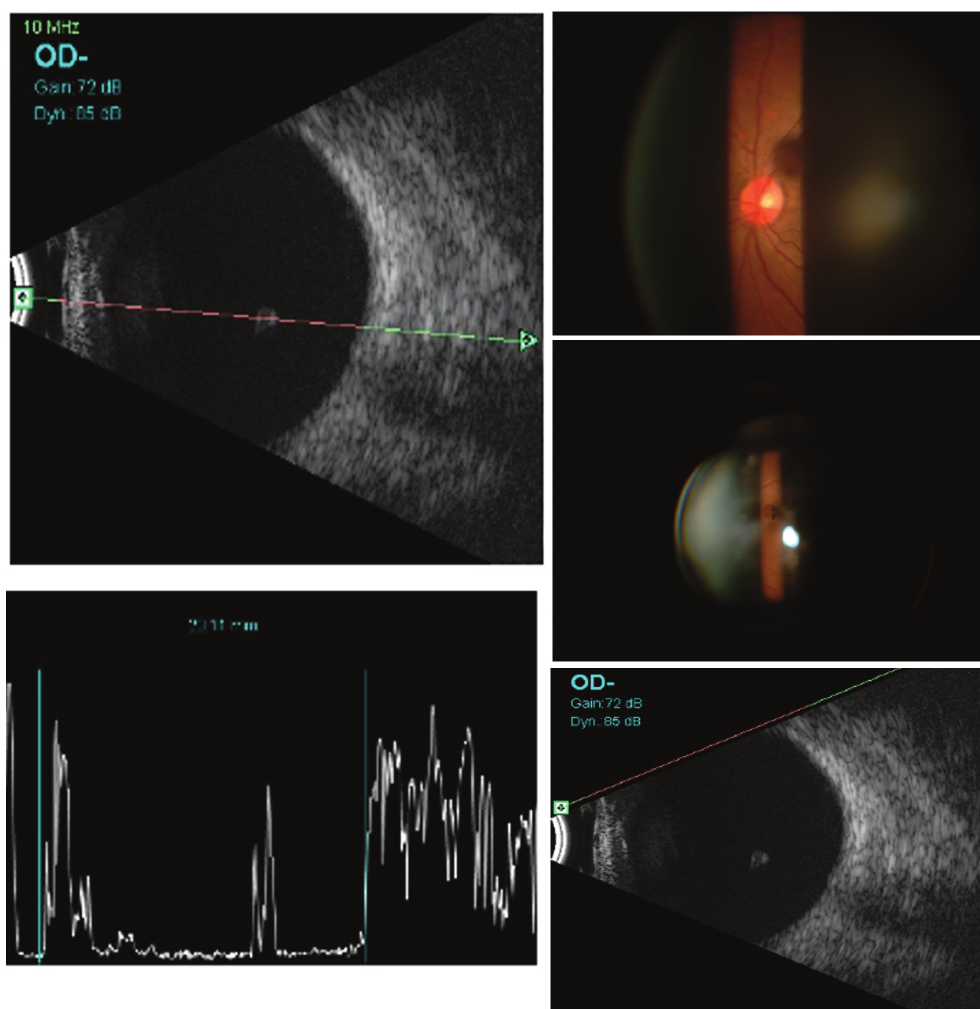
Figure 1. B-mode ultrasound with a 10 MHz probe showing a free-floating globule in the vitreous with a hyperechoic surface, and hypoechoic interna, suggestive of a vitreous cyst. Corresponding A-mode ultrasound shows to be normal. Slit lamp biomicroscopy photographs showing a cyst in the vitreous and a normal posterior pole of the right